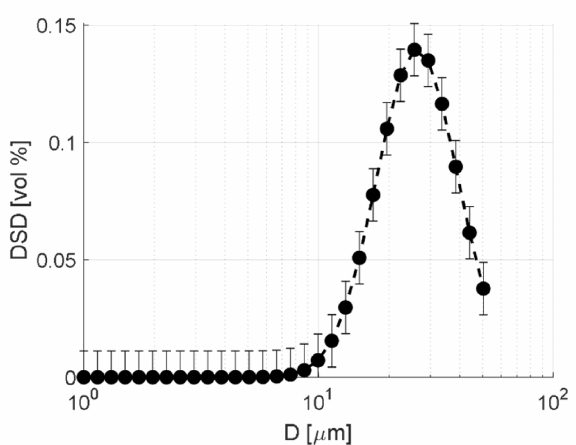
Figure 1. The lognormal distribution used as the pre-emulsion DSD in the study. Error bars show plus/minus one expanded standard uncertainty, for the case of a 4% relative uncertainty (test I).